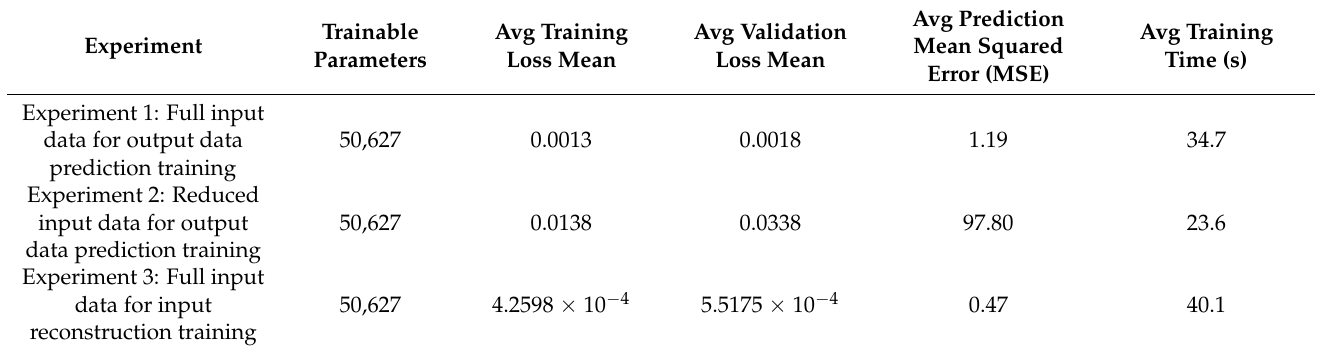
Table 4. Comparison of training results for the input/output mapping neural network (NN) on the full dataset, the input/output mapping NN on the reduced dataset and the input reconstruction NN; where avg is shorthand for average.